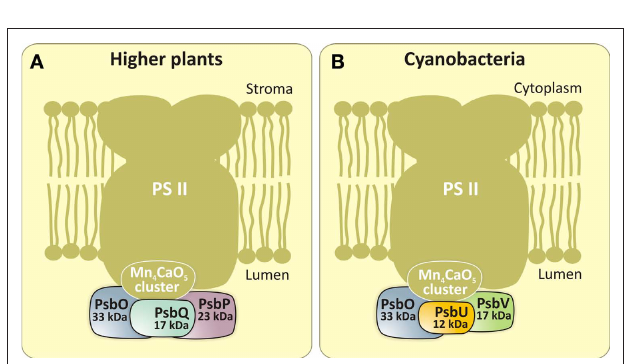
FIgurE 3 | Extrinsic proteins on the lumenal side of PSII in higher plants (A) and cyanobacteria (B). PsbO (33 kDa), PsbQ (17 kDa) and PsbP (23 kDa) are the extrinsic proteins found in higher plants. In cyanobacteria, two of these proteins (PsbP and PsbQ) are replaced by PsbU (12 kDa) and PsbV (Cyt c 550, 17 kDa). For a discussion of lipidated extrinsic proteins in cyanobacteria (CyanoP, CyanoQ, and Psb27), see recent review by Fagerlund and Eaton-Rye (2011). Both in higher plants and cyanobacteria, these proteins stabilize the